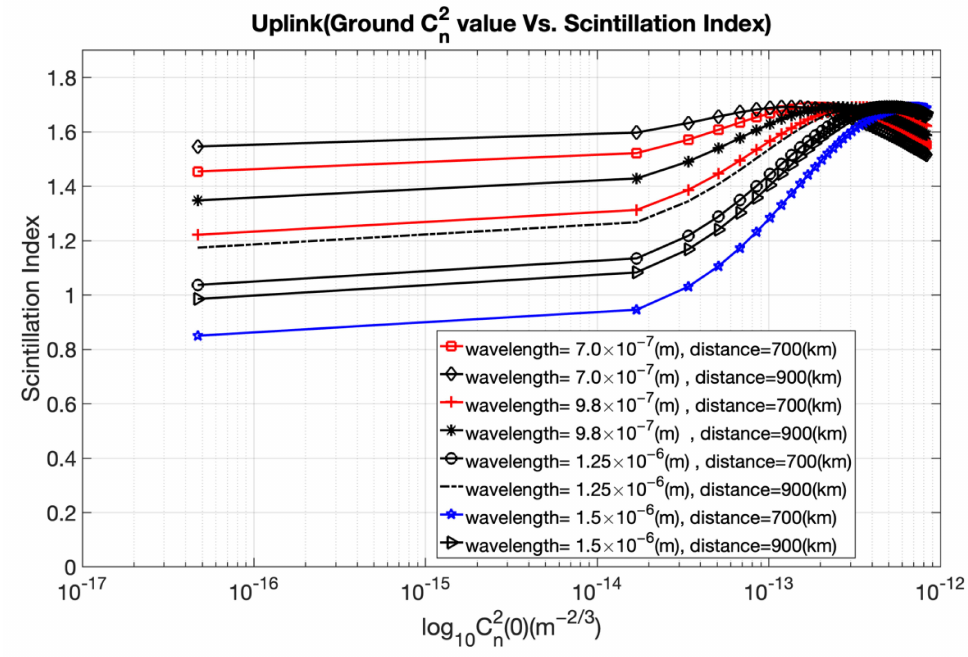
Figure 6. Variation in the scintillation index in an uplink channel.